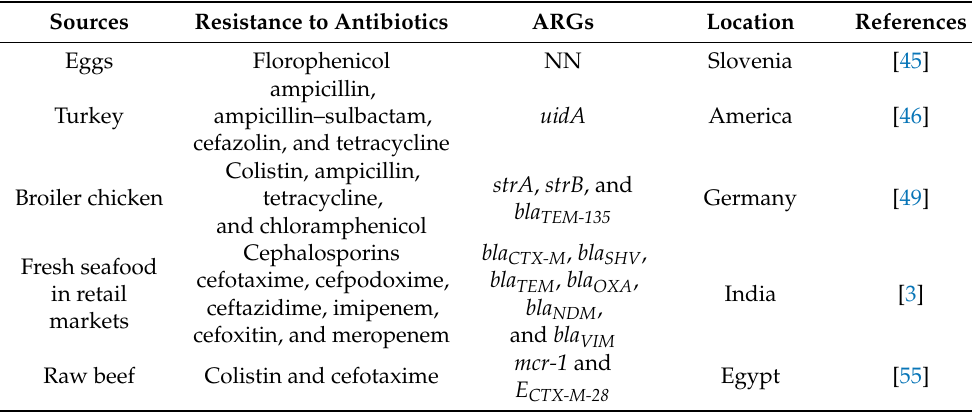
Table 1. AR E. coli and its ARGs in food animals and products